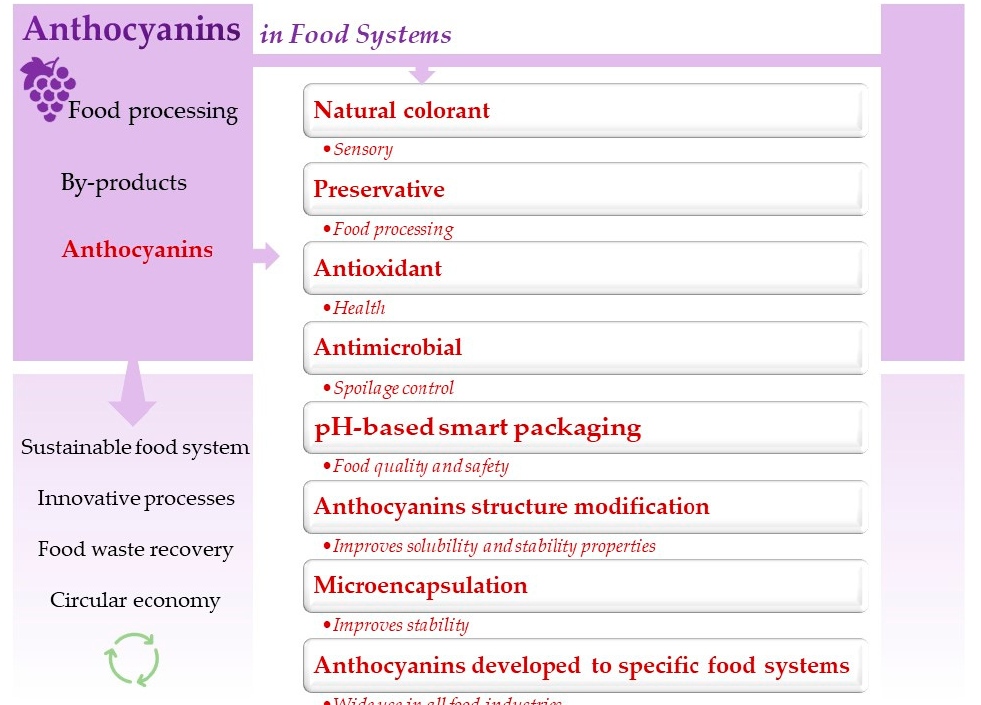
Figure 3. Anthocyanins can be recovered from food agri-food by-products. It is an important strategy to improve the food chain, especially to develop a sustainable food system, by using innovative processes and a food waste recovery approach. The second part of this figure (right) brings the anthocyanin uses commonly described by literature and industry, such as natural colorants, preservatives, antioxidants, antimicrobials, and health-promoting agents, as well as the innovative uses recently described in scientific reports; for instance, the pH anthocyanin-based smart packaging, and anthocyanin structure modification. Microencapsulation with macromolecules, such as proteins and polysaccharides, has been reported to enhance the anthocyanins’ stability during food processing and storage and over the human gastrointestinal digestion system. Food systems present different behavior and, as a consequence, the food technologists should carefully develop anthocyanin formulations appropriate to these specific systems using, for example, the strategies presented herein. Certainly, novel purposes will appear over time about these multi-property biomolecules. Nevertheless, the literature data clearly demonstrate that the food industry may extensively explore anthocyanins as food additives and functional